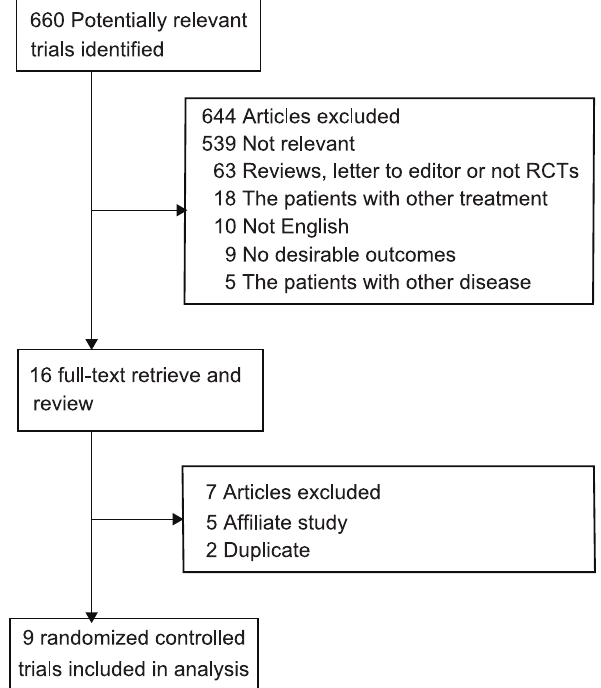
Figure 1. Flow diagram of the literature search and trials selection